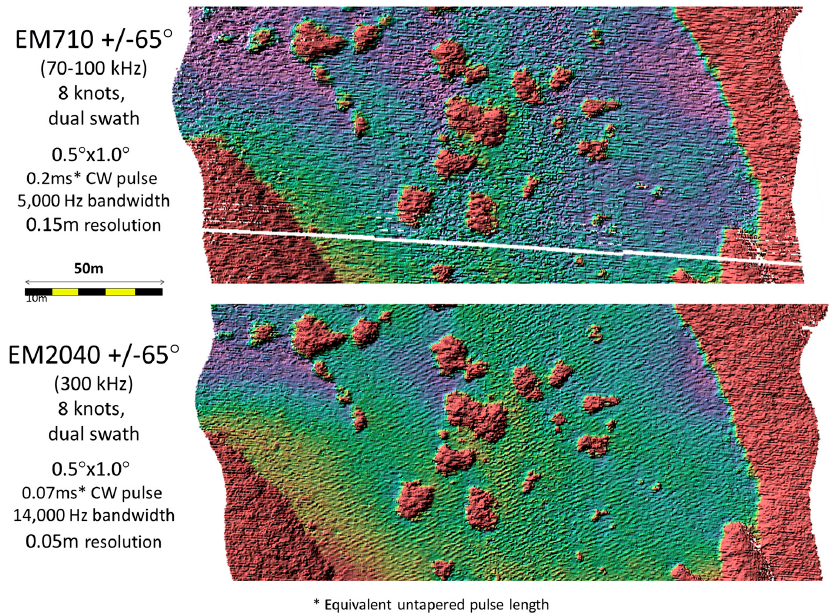
Figure 7. Two ±65° swaths of multibeam data collected simultaneously from the same vessel over a seabed in ~35 m water depth. Both sonars have the same transmit and receive beam widths (0.5° × 1.0°). The higher frequency system, however, employs a shorter (higher bandwidth) pulse length (CW: continuous wave). The impact of this is clear in the definition of the short wavelength ripples which are not resolved using the longer pulse.